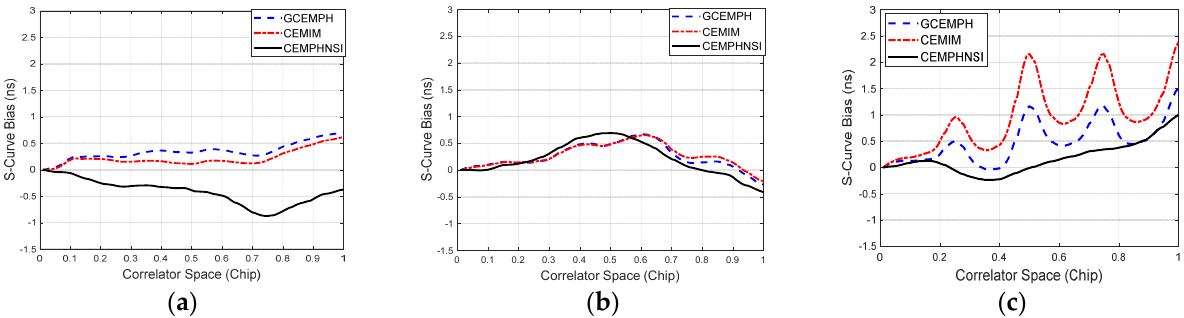
Figure 9. ( a ) The S-Curve bias of 3 multiplexing signals with signal s 1 ; ( b ) The S-Curve bias of 3 multiplexing signals with signal s 2 ; ( c ) The S-Curve bias of 3 multiplexing signals with signal s 3 .